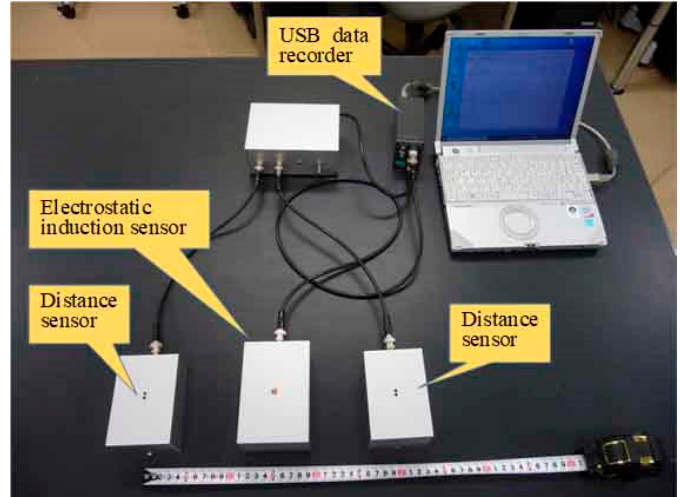
Figure 3. Photograph of the sensor system for the measurement of the electric potential of the human body by palm movement.